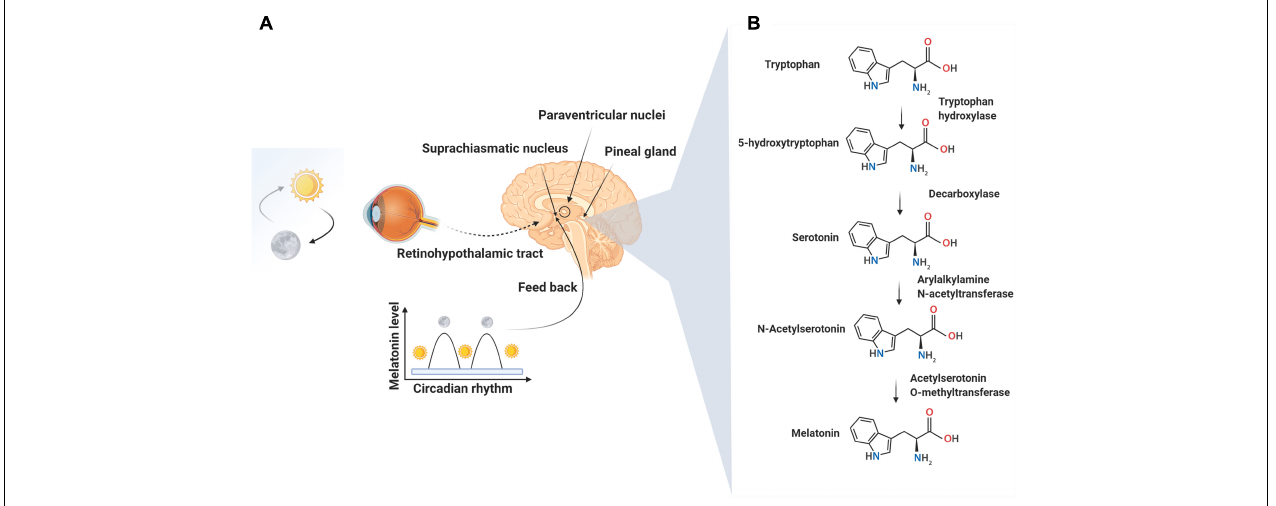
FIGURE 1 | Neural control of melatonin synthesis in the pineal gland (A) . Melatonin, a well-known sleep-promoting molecule, is produced in the pineal gland as summarized in this figure. The secretion of melatonin is tightly controlled by suprachiasmatic and paraventricular nuclei in response to the light: dark cycle and the circadian clock mechanisms of the suprachiasmatic nuclei. The peak secretion of melatonin occurs at night time and reaches minimum levels at day. The synthesis of melatonin is a result of the enzymatic conversion of tryptophan to melatonin via the intermediate, molecule, serotonin (B)